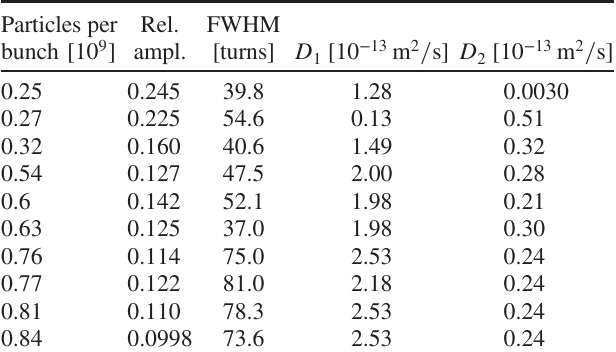
TABLE III. Diffusion coefficients ð D 1 ; D 2 Þ found using the amplitude and the FWHM values from the turn by turn